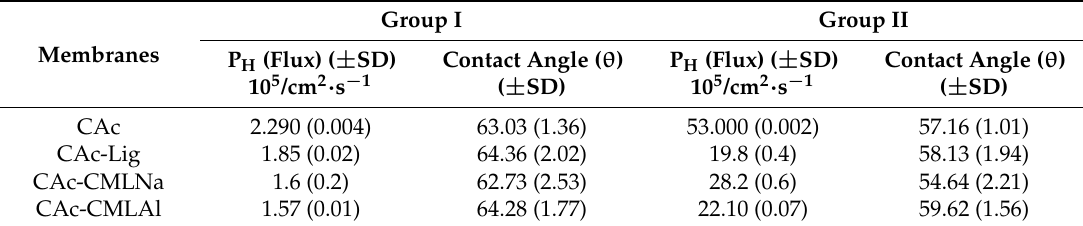
Table 3. Interactions of the membranes with water (flux and contact angle).